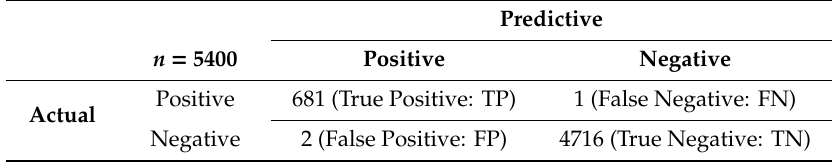
Table 6. The binary confusion matrix for the RDP application label in the multi-layer LSTM model